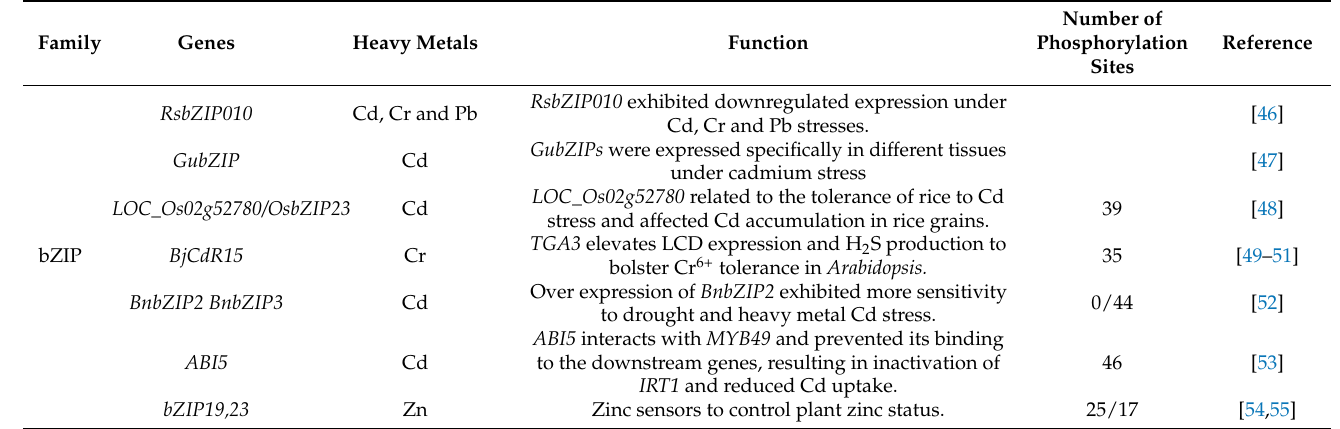
Table 2. Transcriptional factors in response to heavy metal